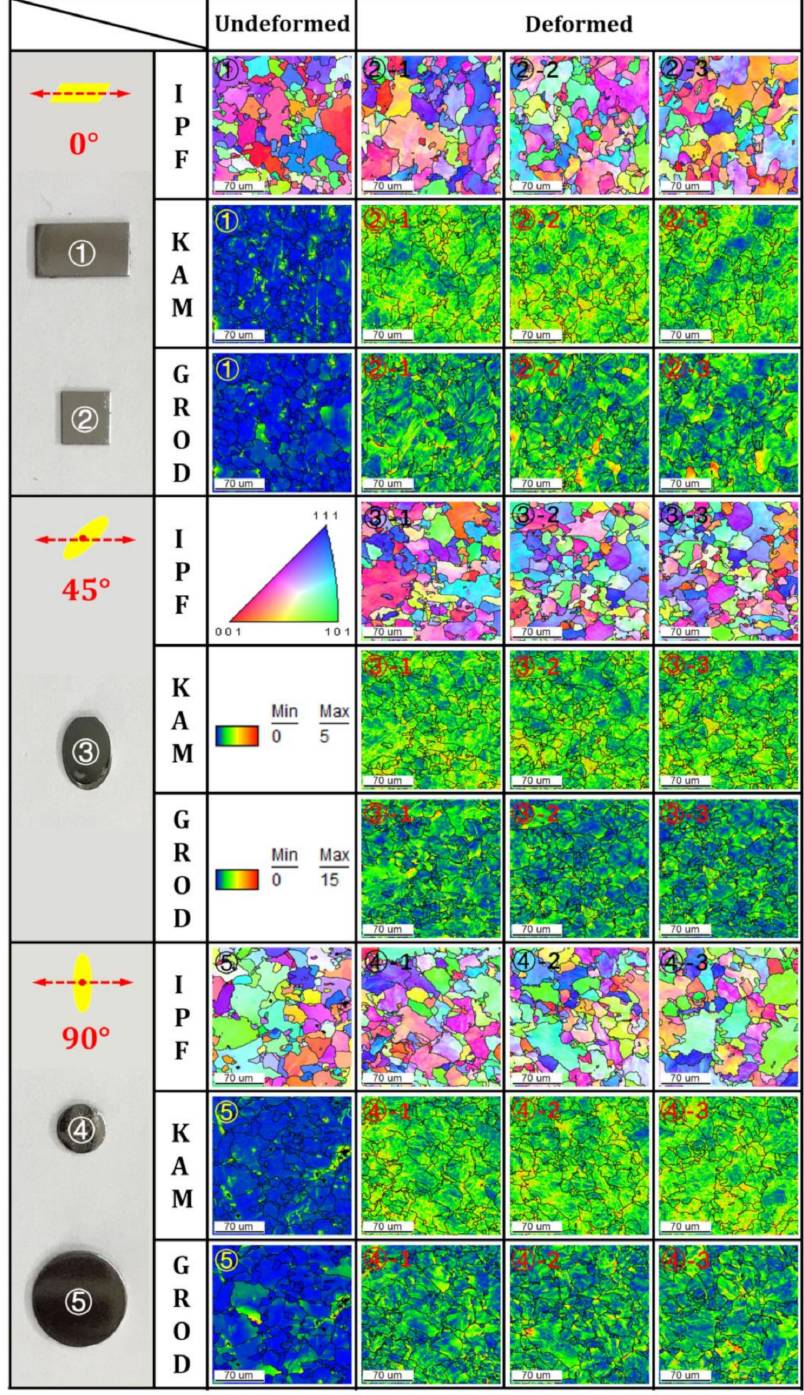
Figure 5. IPF , KAM and GROD maps given by 2D-EBSD observations on planes with different angles to loading axis in both undeformed clamp sections and deformed gauge